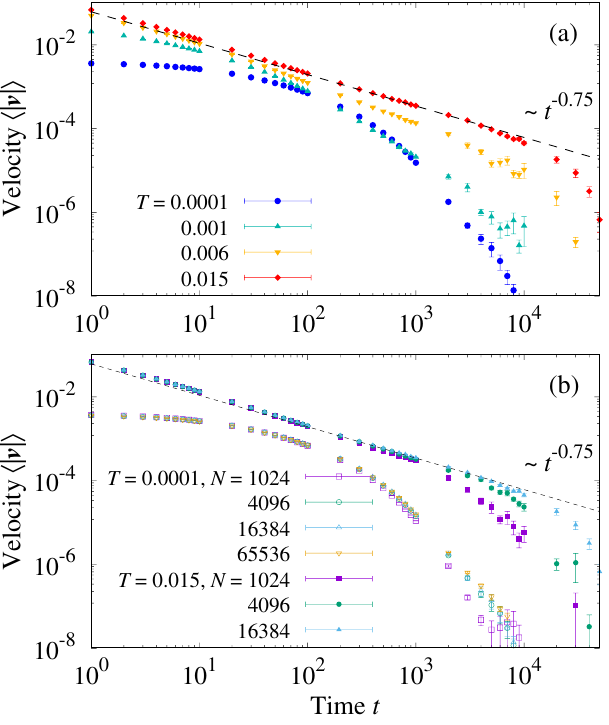
FIG. 1. (a) Velocity hj v ð t Þji as a function of time t in the Mari- Kurchan soft-sphere model at several temperatures with N ¼ 16384 . (b) Velocity decay at two selected initial equilibrium temperatures and several system sizes. The dashed line indicates β ¼ 0 . 75